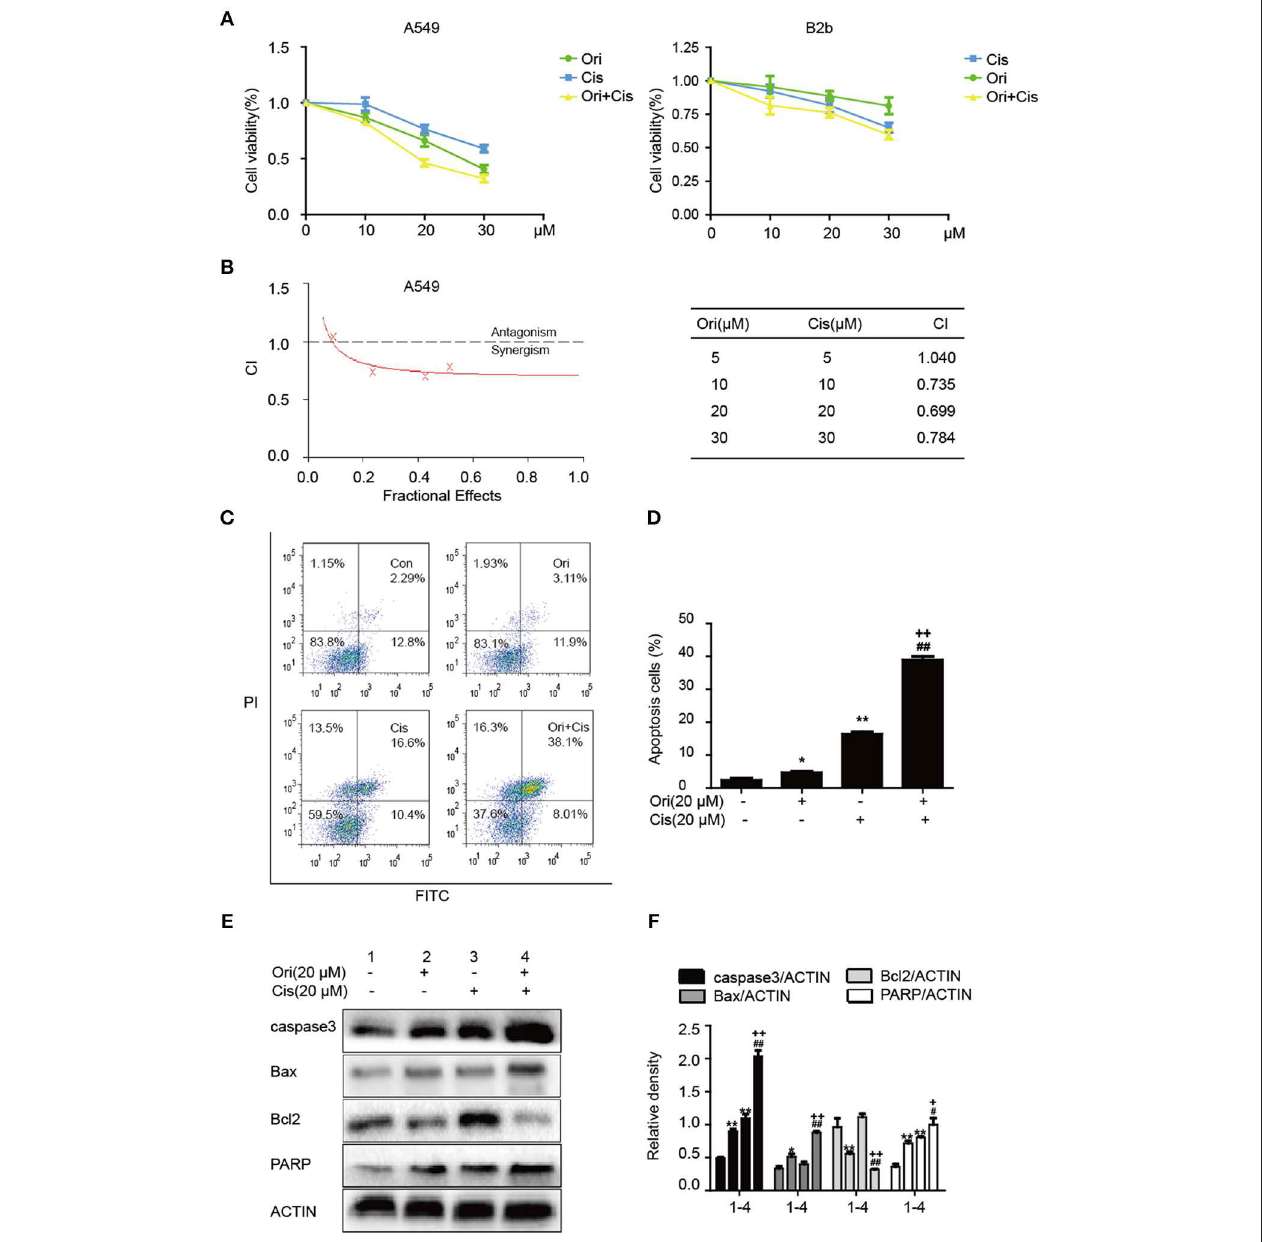
FIGURE 5 | Ori enhances chemotherapeutic sensitivity through the activation of apoptosis. (A) A549 cells were treated with different doses (10, 20, and 30 µ M) of Ori in the absence or presence of cisplatin (10, 20, and 30 µ M) for 18h. Cell viability was calculated as the percentage relative to untreated cells which were considered as 100%. (B) Data was added into CalcuSyn and combination index (CI) was analyzed in this experiment. CI < 1 indicates synergism, while CI > 1 indicates antagonism. A549 cells were exposed to Ori (20 µ M) in the absence or presence of cisplatin (20 µ M) for 18h. (C,D) The percentages of apoptotic and necrotic cells were determined by flow cytometry. (E,F) Western blots and statistical results showed the protein levels of caspase3, Bax, Bcl2, and PARP. The results showed the average of three independent experiments. * p < 0.05 and ** p < 0.01 vs. the control group. # p < 0.05 and ## p < 0.01 vs. the Ori group. + p < 0.05 and ++ p < 0.01 vs. the Cis